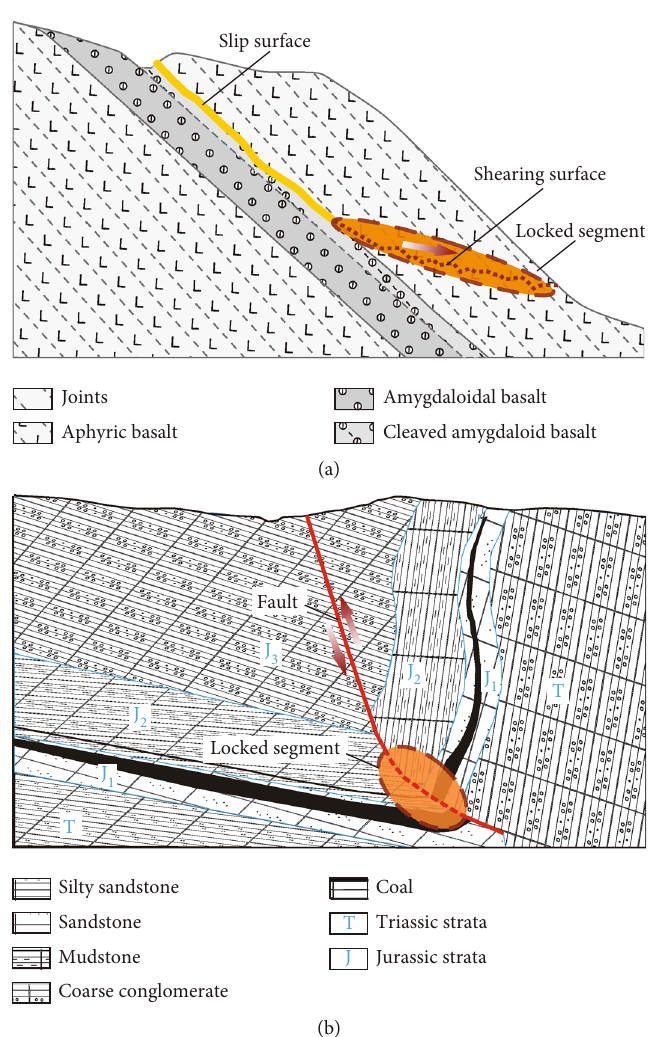
Figure 1: Conceptual model of locked segments in slip surface of rock slope (a) and seismogenic faults of rock underground engineering (b) (modi fi ed from Chen and Kong [15], Huang and Xu [16], Jiang et al. [17], and Song